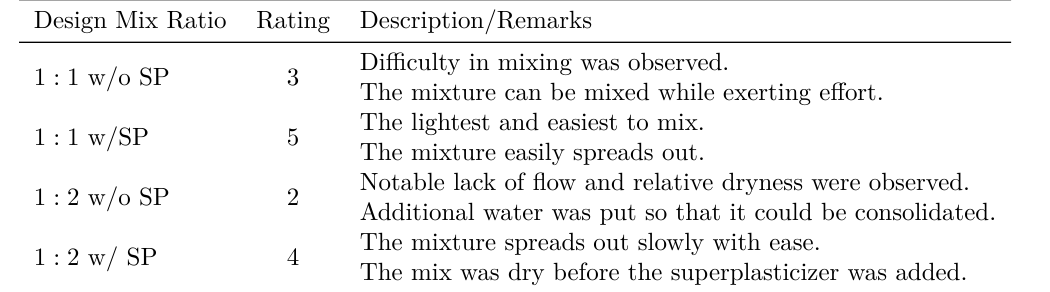
Table 2. Design Mix of Geopolymer Concrete.